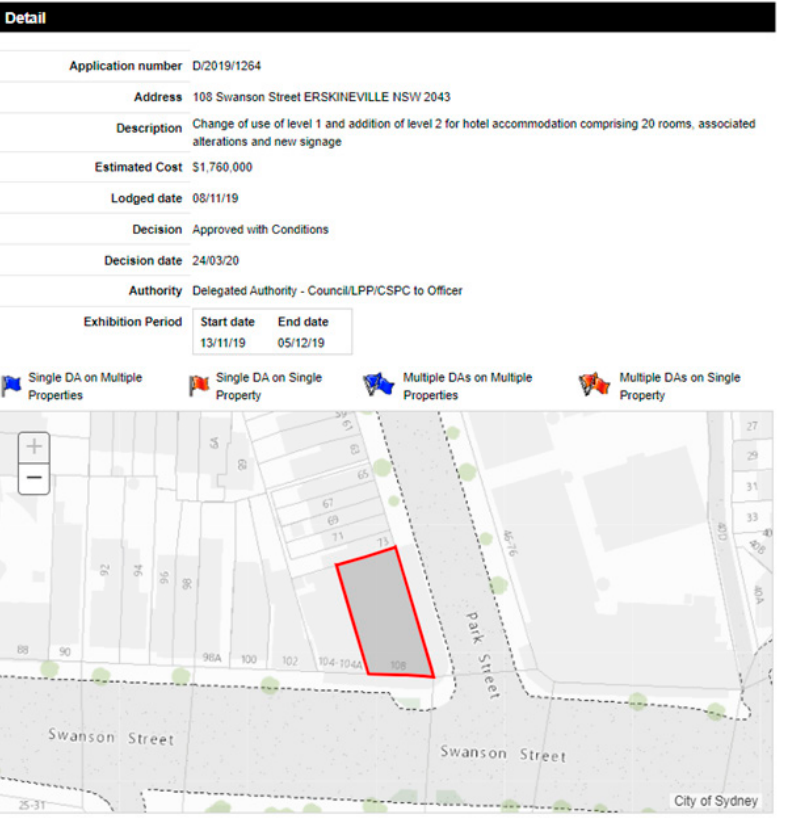
Figure 3. Snapshot of CoS webpage for a single DA (DA site outlined in red) (https://online2.cityofsydney.nsw.gov.au/DA/IndividualApplication?tpklapappl=1454583, accessed on 3 May 2021).